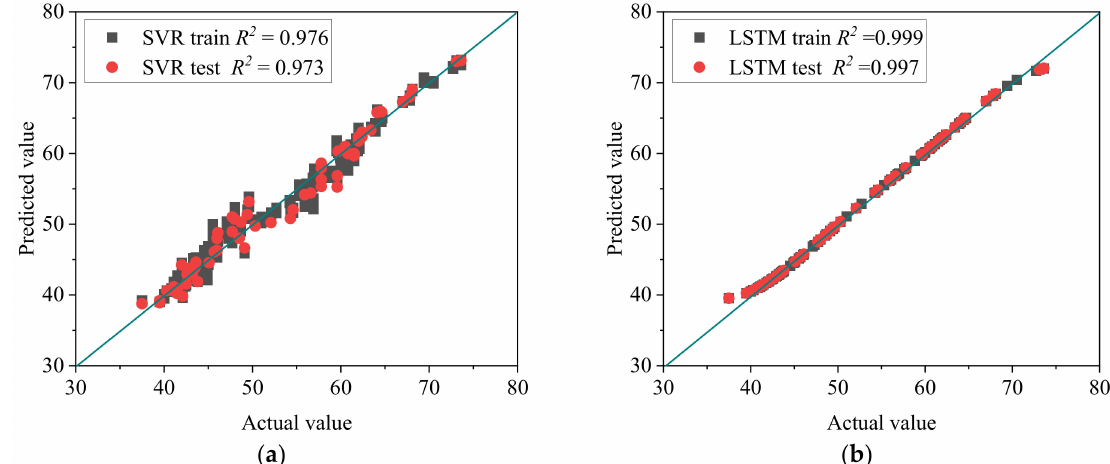
Figure 6. Relationship between actual values of compressive strength and predicted values: ( a ) SVR model; ( b ) LSTM model.